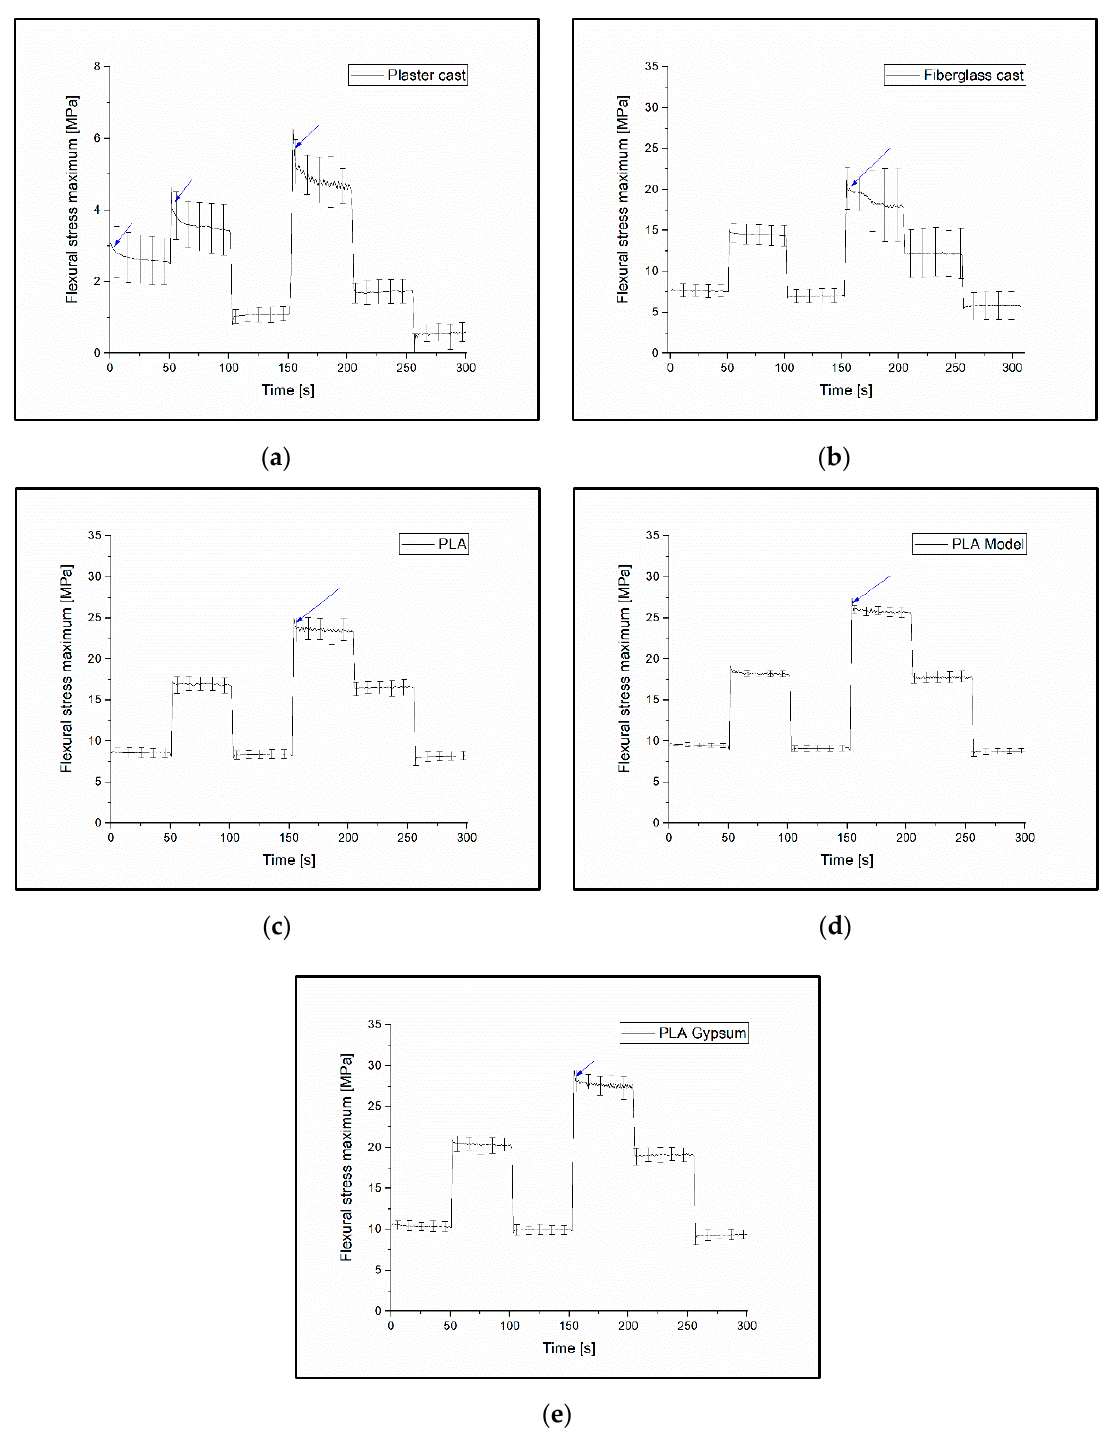
Figure 9. Measured values of the variable load cyclic tests. The blue arrows show the points at which permanent changes have occurred in the materials: ( a ) plaster cast, ( b ) fiberglass cast, ( c ) PLA, ( d ) PLA Model, and ( e ) PLA Gypsum (the results show the materials that did not have a break point on the curves in the fatigue test; these were able to reproduce the previous holding force after a higher load under the same deflection).